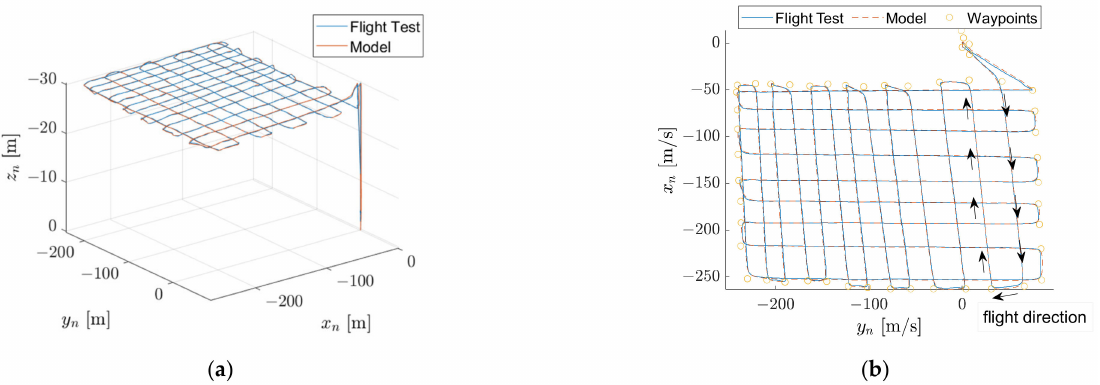
Figure 16. The comparison of trajectories between reality and simulation: ( a ) 3D view of the trajectory and ( b ) 2D plot of the drone trajectory.